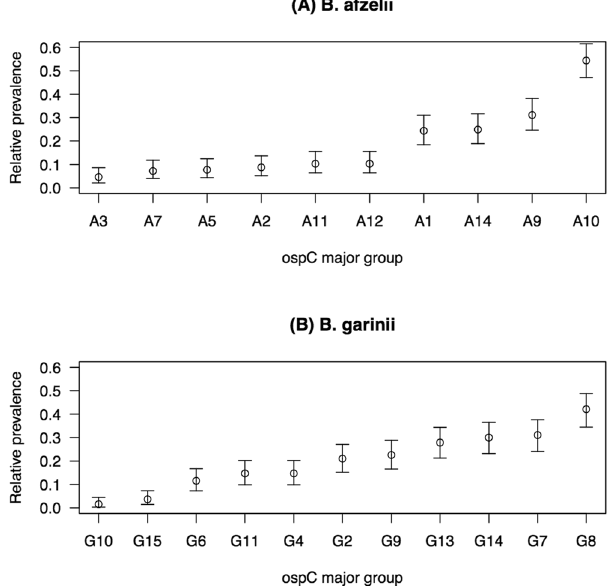
Figure 1. The relative prevalences differ significantly among the oMGs in ( A ) B. afzelii and in ( B ) B. garinii . For each species, the oMGs are ranked from least common to most common. The relative prevalence of an oMG strain is defined as the proportion of B. afzelii -infected nymphs that are infected with that particular oMG strain.